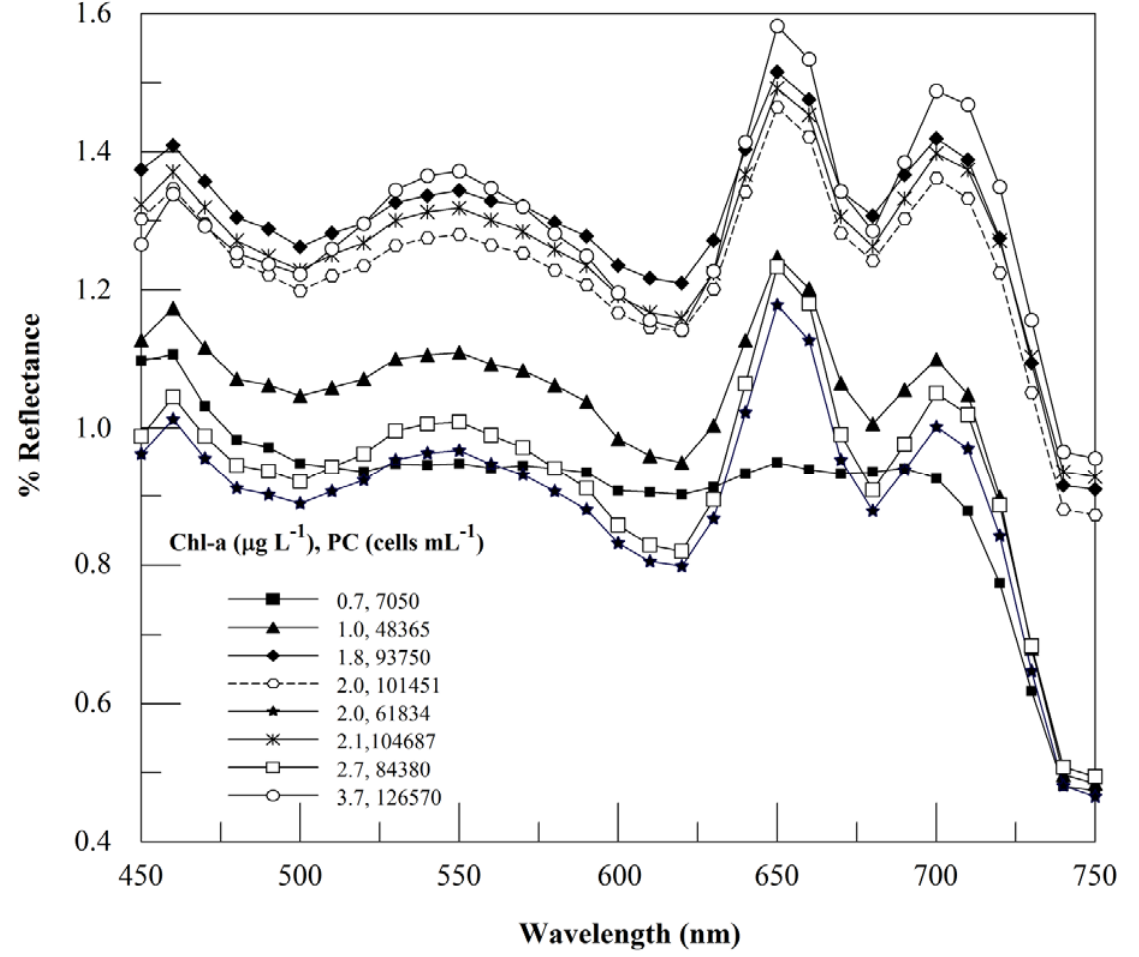
Figure 3. Percent reflectance spectra of Synechocystis and Anabaena showing appearance and dynamics of 650 nm peak at different Chl- a